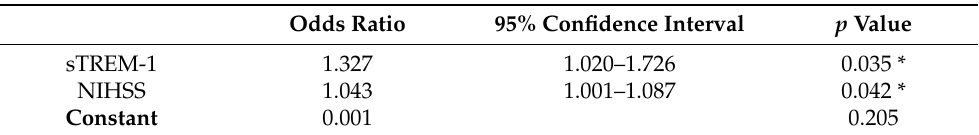
Table 5. Binary logistic regression models for risk factors and the Barthel index in patients with